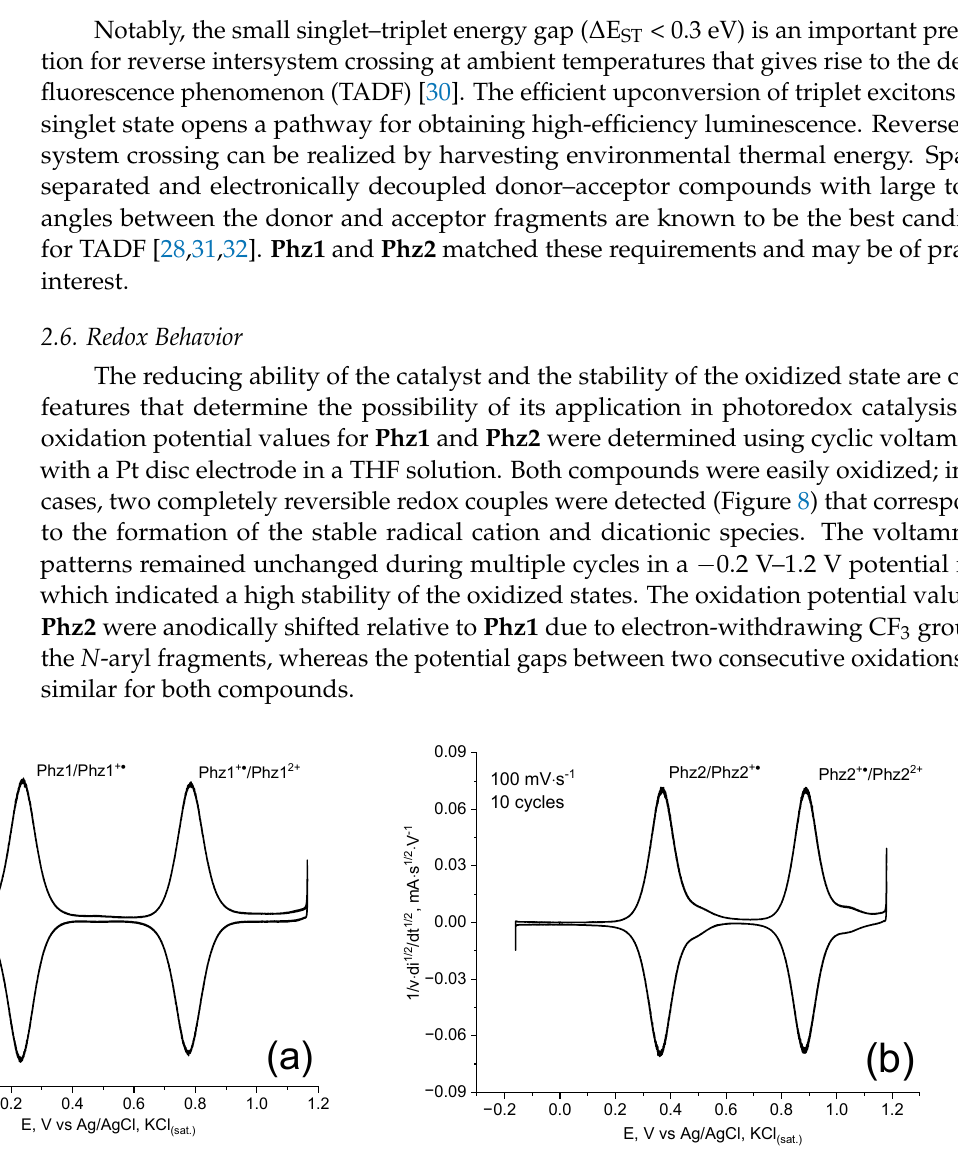
Figure 8. Semi-differential voltammograms obtained for Phz1 ( a ) and Phz2 ( b ) upon multiple cycles in a − 0.2 V–1.2 V potential range (Pt, THF, 0.2 M Bu 4 NBF 4 100 mV/s, 10 cycles).